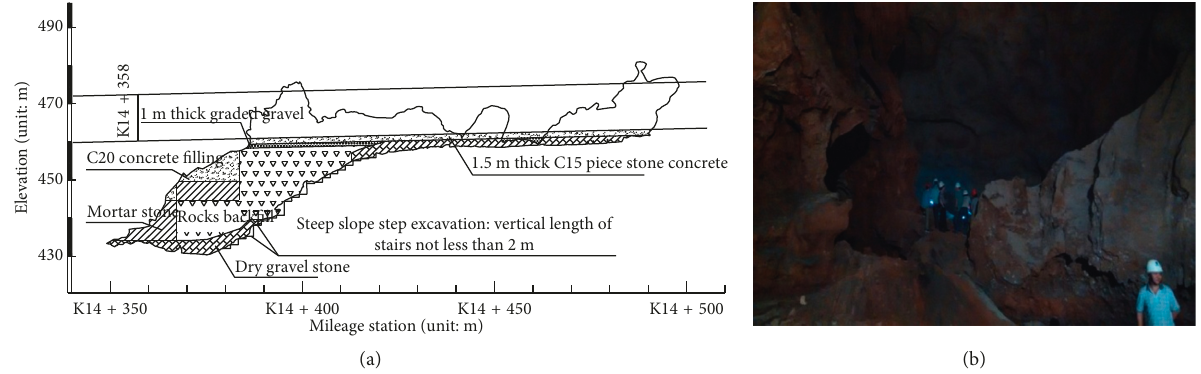
Figure 1: Tunnel and karst geomorphology: (a) the position of the tunnel and karst cave; (b) the original landform of the karst